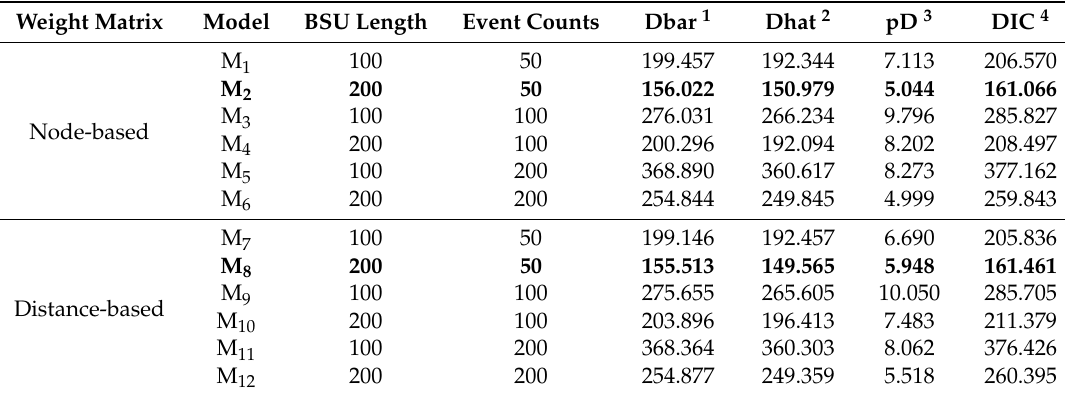
Table 1. The results of the proposed method under different scenarios.